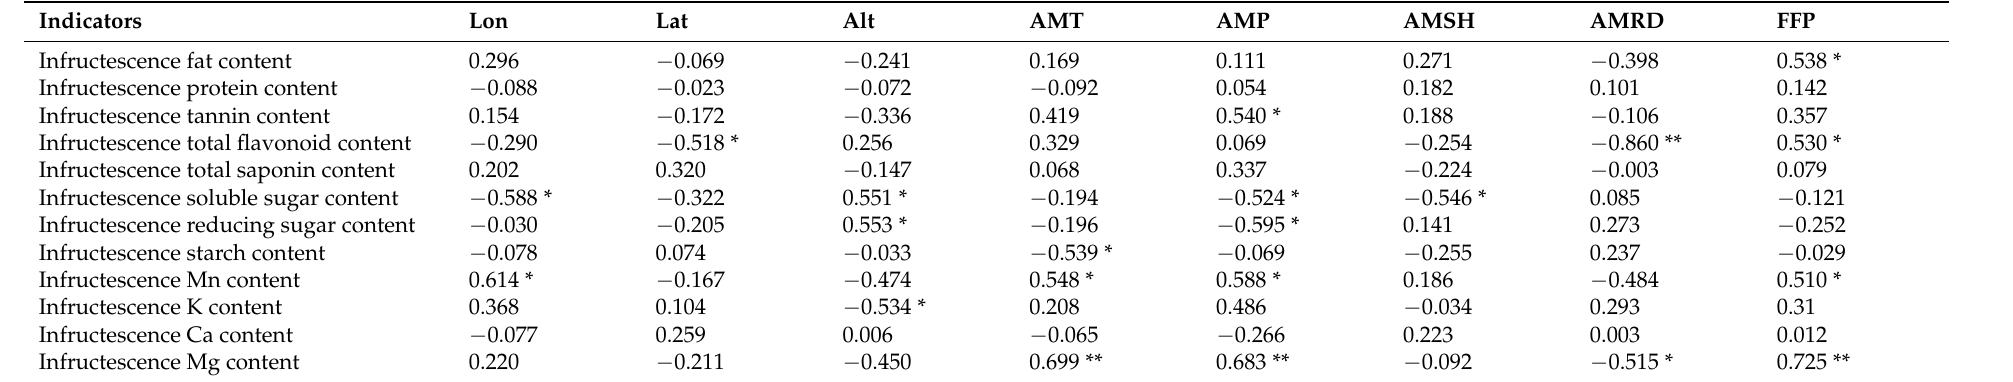
Table A4. Correlative analysis between quality traits and environmental factors of H. acerba